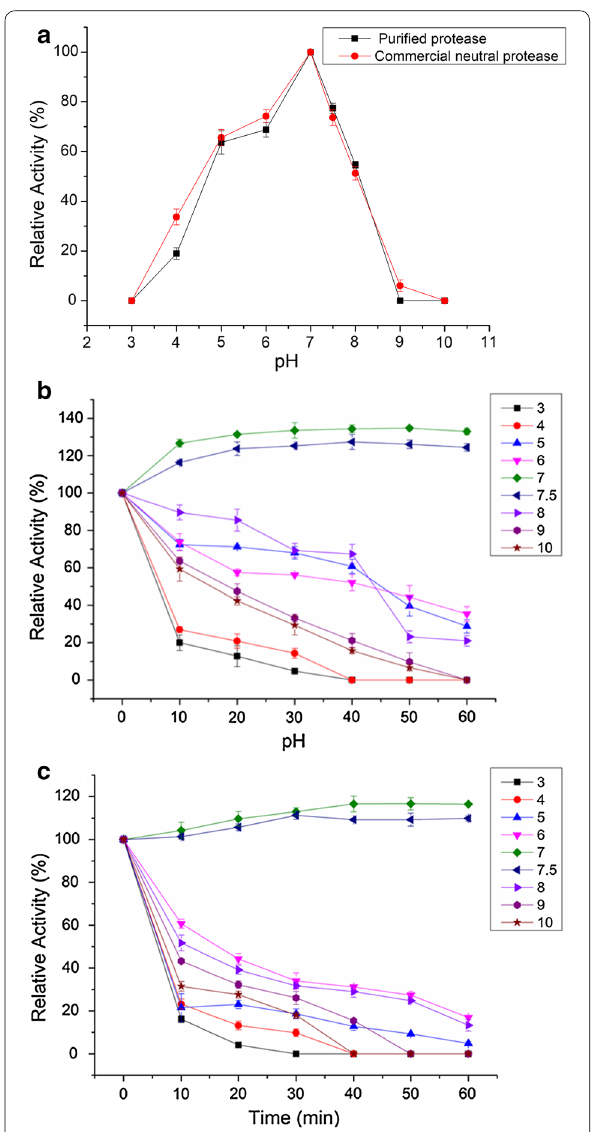
Fig. 3 a Effect of pH on protease activity; b stability of purified protease at different pH, at 4 °C; c stability of commercial neutral protease at different pH, at 4 °C Fig. 4 a Effect of temperature on protease activity; b stability of